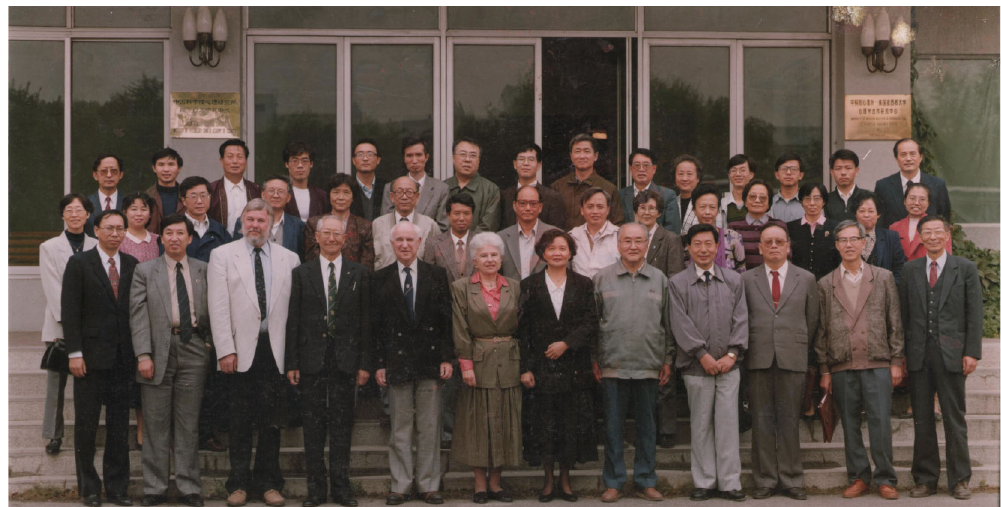
Figure 3. On October 10th, 1994, Jiao Shao (the fi rst row, the fi fth from right) attended the founding conference of the Center for Brain and Behavior Research in IPCAS.